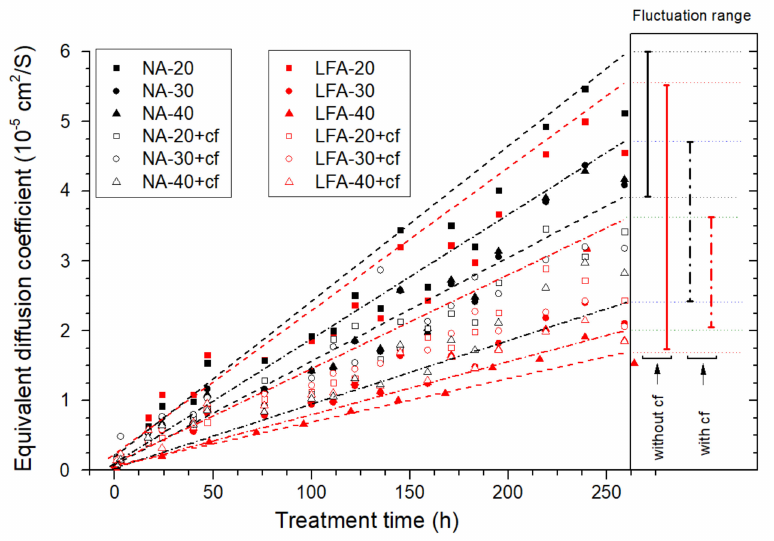
Figure 9. The time-dependent variation in the calculated equivalent diffusion coefficient of the anode samples prepared with different mixture proportions of secondary anode